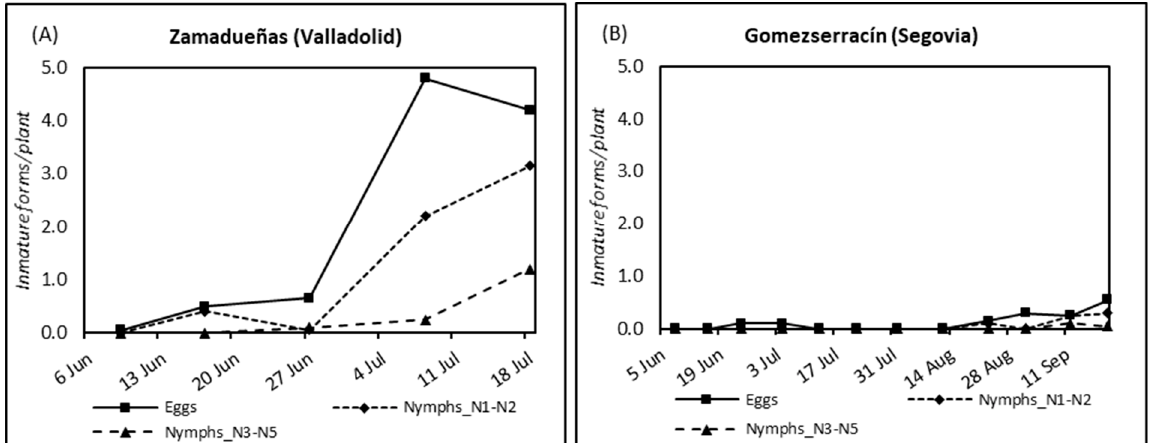
Figure 3. Mean of number of psyllid eggs per plant by visual inspection, number of nymphs per plant N1-N2, and nymphs per plant N3-N5 found in 2016 in ( A ) Zamadueñas (Valladolid) and ( B ) Gomezserracín (Segovia). X-axis represents collection dates and Y-axis values represent the mean number of eggs or nymphs per plant among twenty plants.